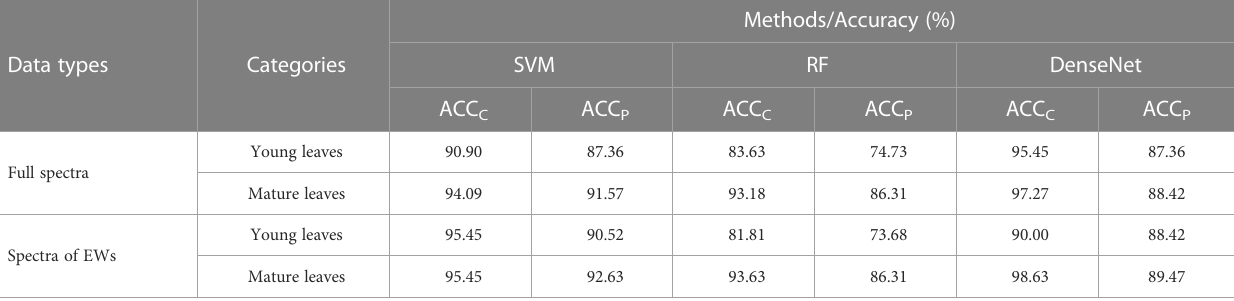
TABLE 2 Classi fi cation results of tomato plant DS based on full spectra and spectra of EWs.